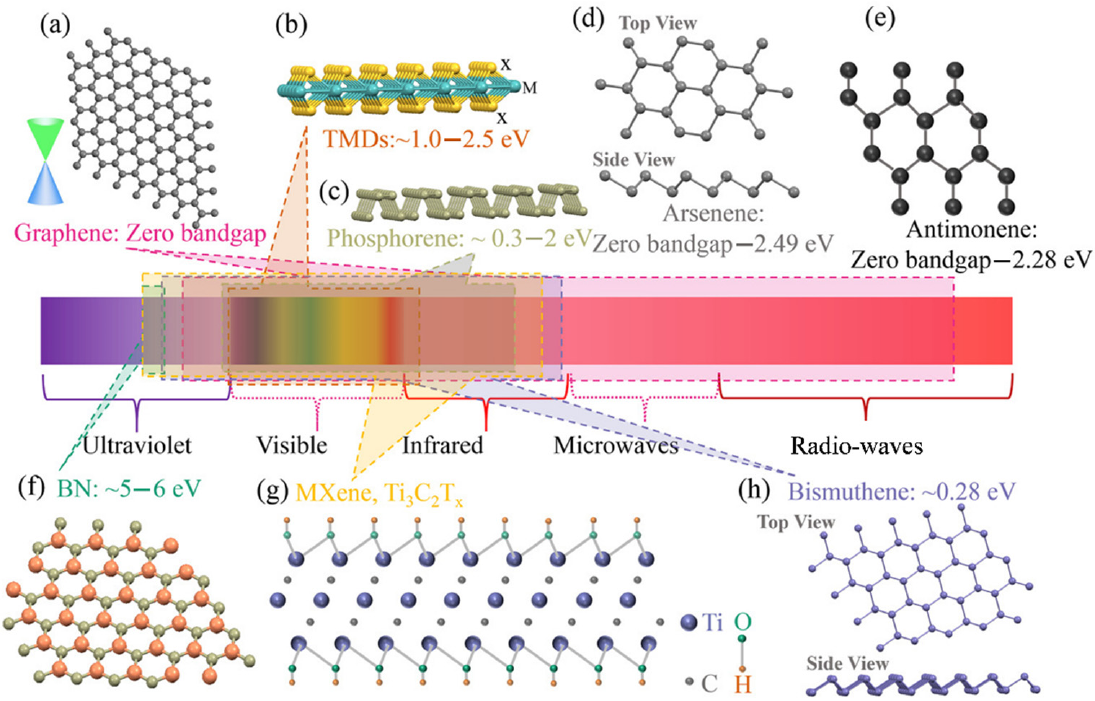
Figure 2. The atomic structure and spectral region of 2D materials. The atomic structure and spectral region of 2D materials such as graphene ( a ), TMDs ( b ), phosphorene ( c ), arsenene ( d ), antimonene ( e ), bismuthine ( f ), MXene ( g ), and BN ( h ). Reproduced with permission [82]. Copyright 2019, Wiley-VCH.